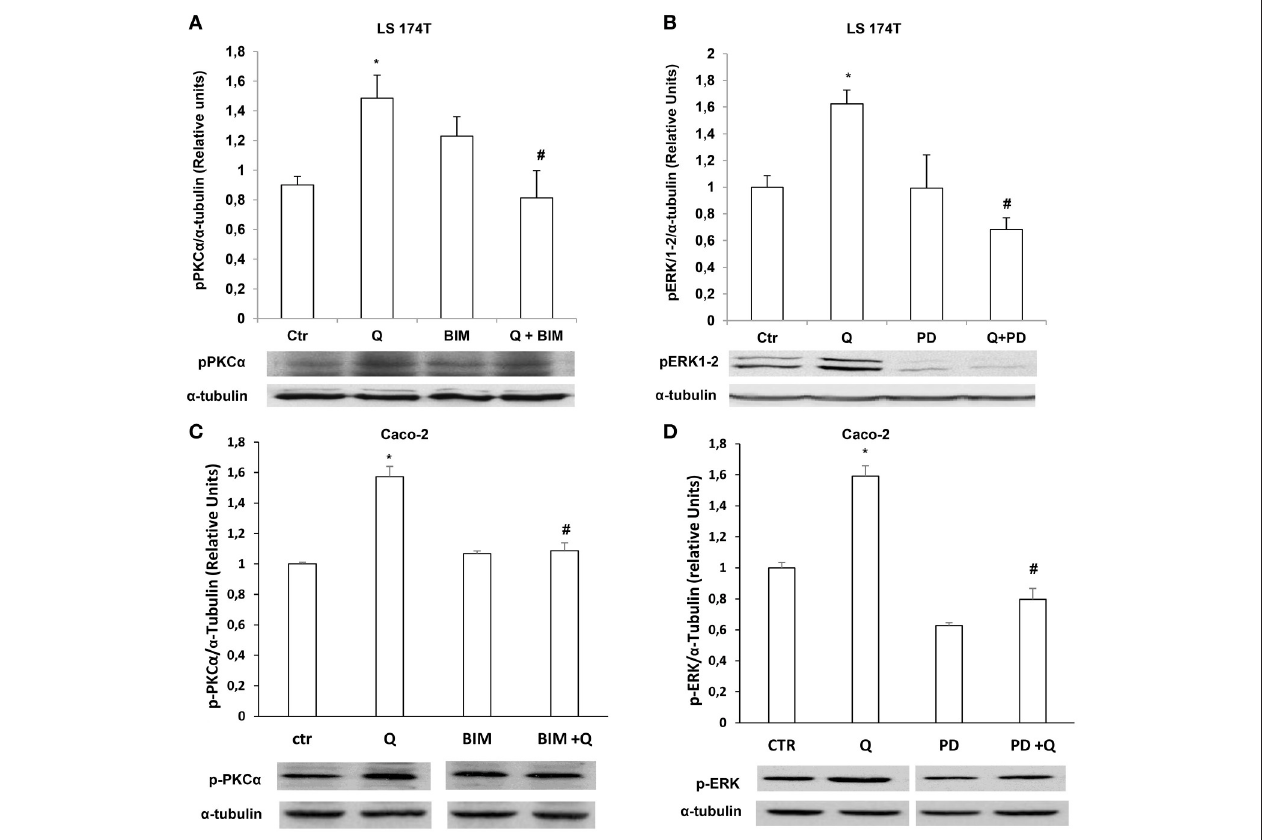
FIGURE 6 | Quercetin activates PKC α and ERK1-2. Western blotting analysis of p-PKC α and p-ERK1-2levels in LS174T (A,B) and Caco-2 (C,D) cells incubated for 18h in MEM without FBS, pretreated for 30min with BIM (PKC inhibitor) or PD98059 (MEK inhibitor) and stimulated with 50 µ M of quercetin. The histogram shows the mean ± SE ( n = 3) obtained by densitometric analysis of p-PKC α and p-ERK1-2 protein bands normalized to α -tubulin of three independent experiments. * p < 0.05 vs. Ctr, # p < 0.05 vs.